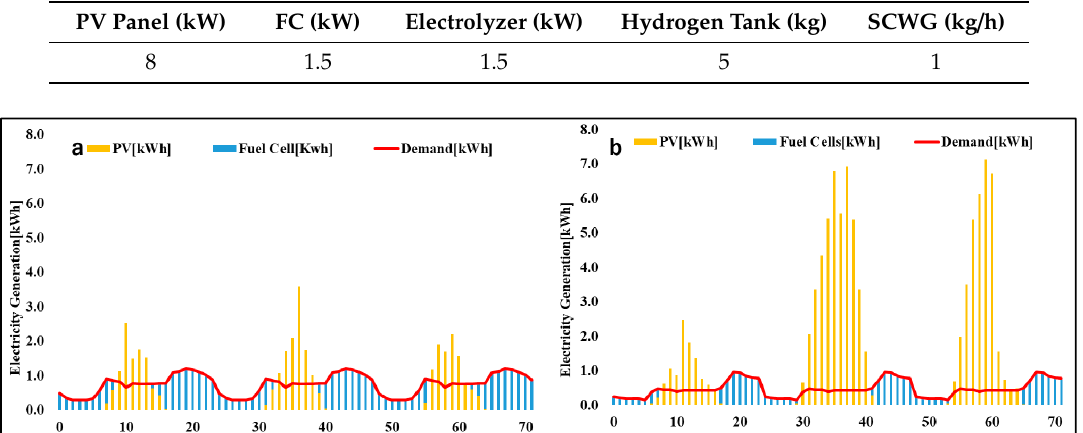
Table 4. Optimal configuration of the proposed HRES in scenario 1.